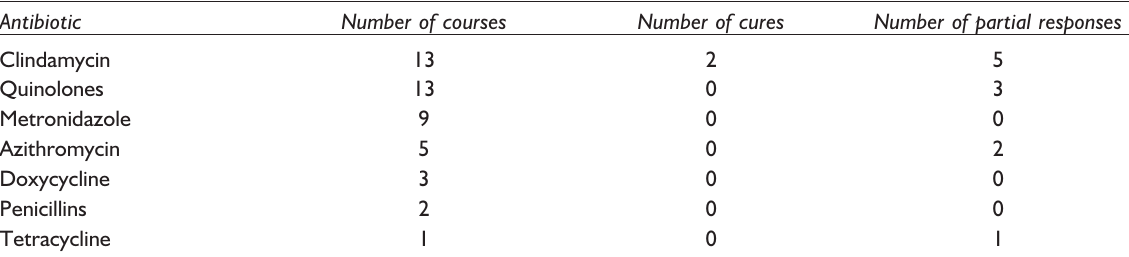
Table 1 Antibiotic effectiveness